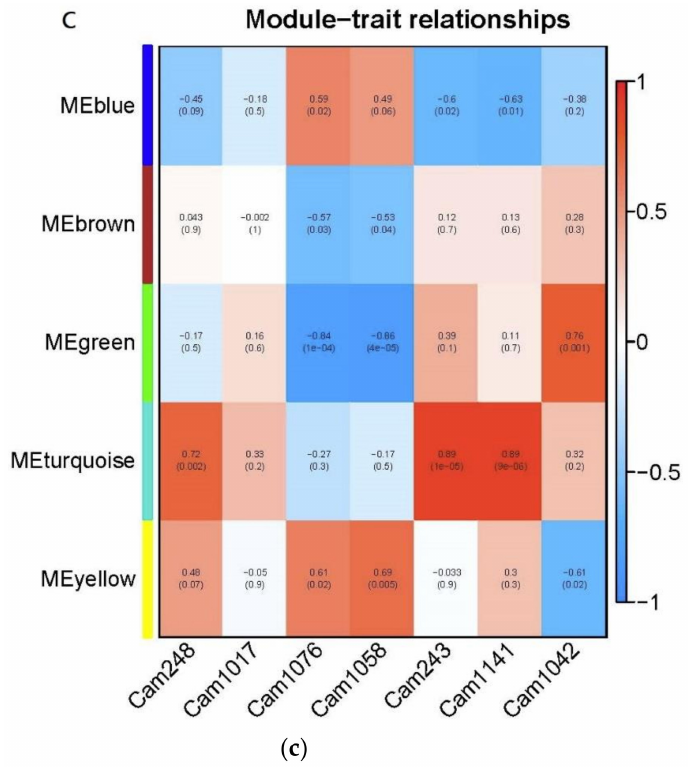
Figure 8. Co-expression and crucial gene screening. ( A ) Clustering results of co-expression modules. Genes in modules are marked with different colors (blue, yellow, brown and turquoise), with grey color representing no genes in any modules. ( B ) Clustering dendrogram. ( C ) Relationships of module and seven different anthocyanins found in BTP